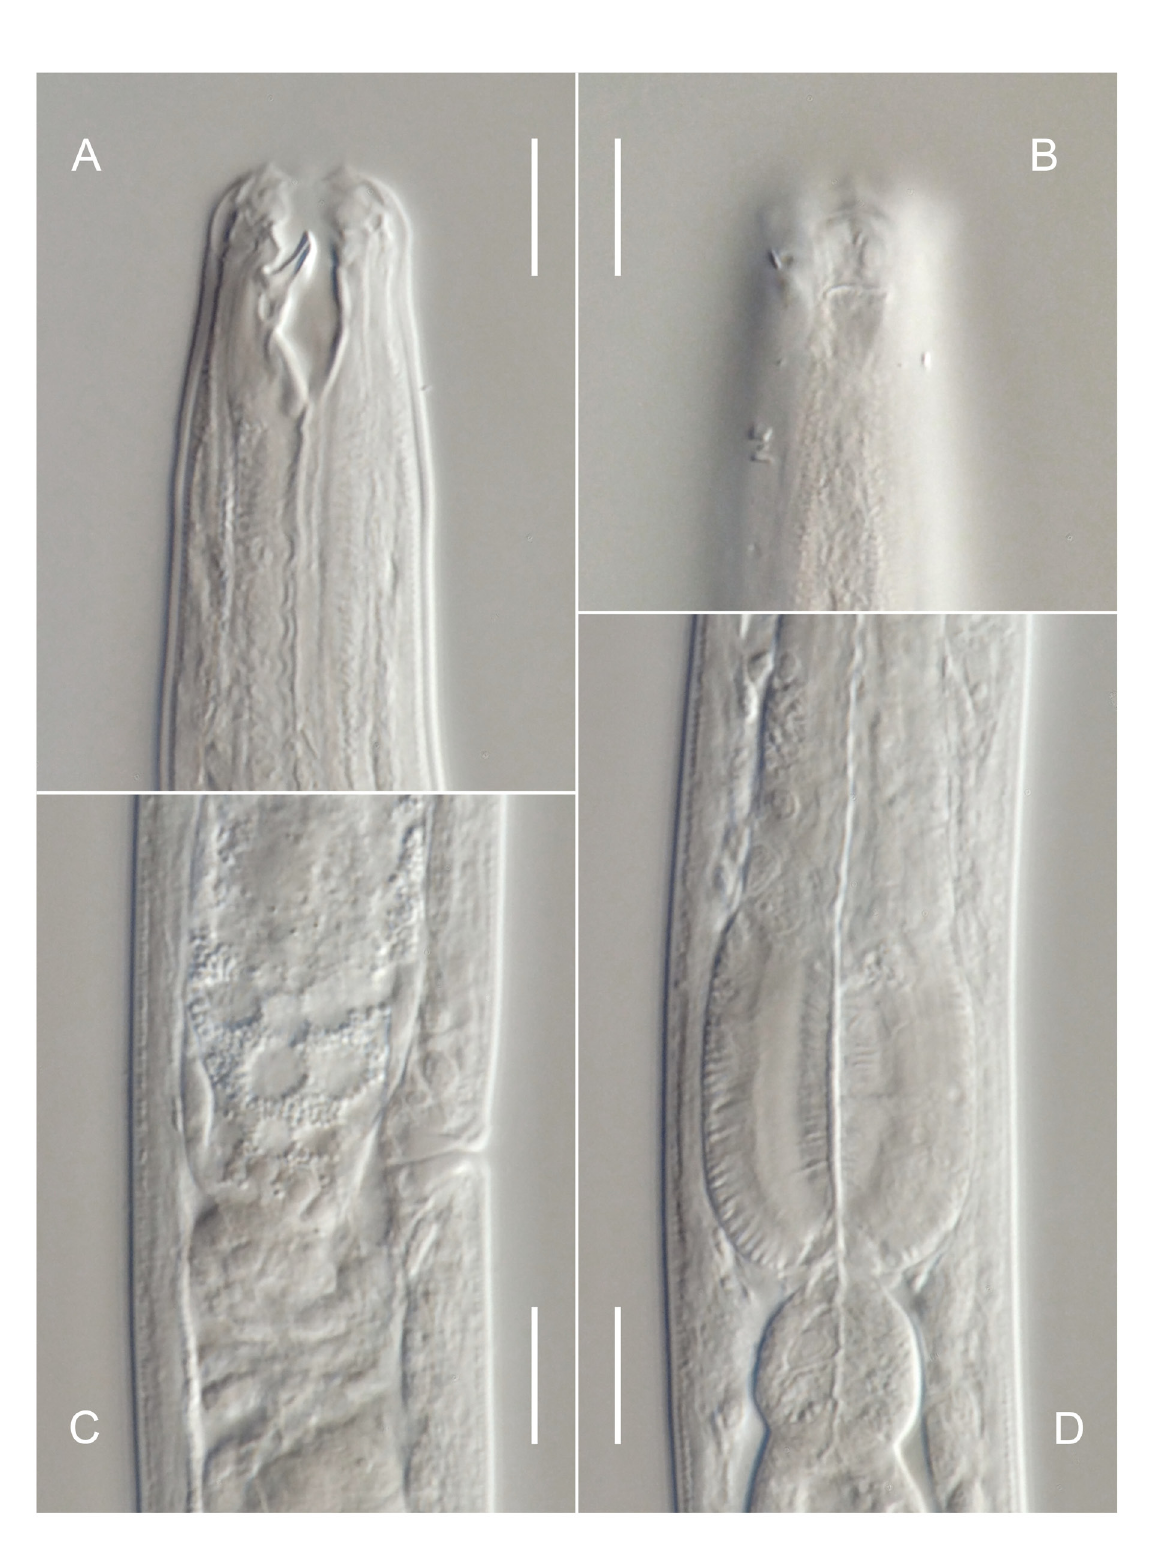
Fig. 4 . Campydoroides manautei Holovachov gen. et sp. nov., non-type female from New Zealand (SMNH-175283). A . Anterior end, median section. B . Anterior end, surface view. C . Vulval region. D . Base of pharynx. Scale bar: 20